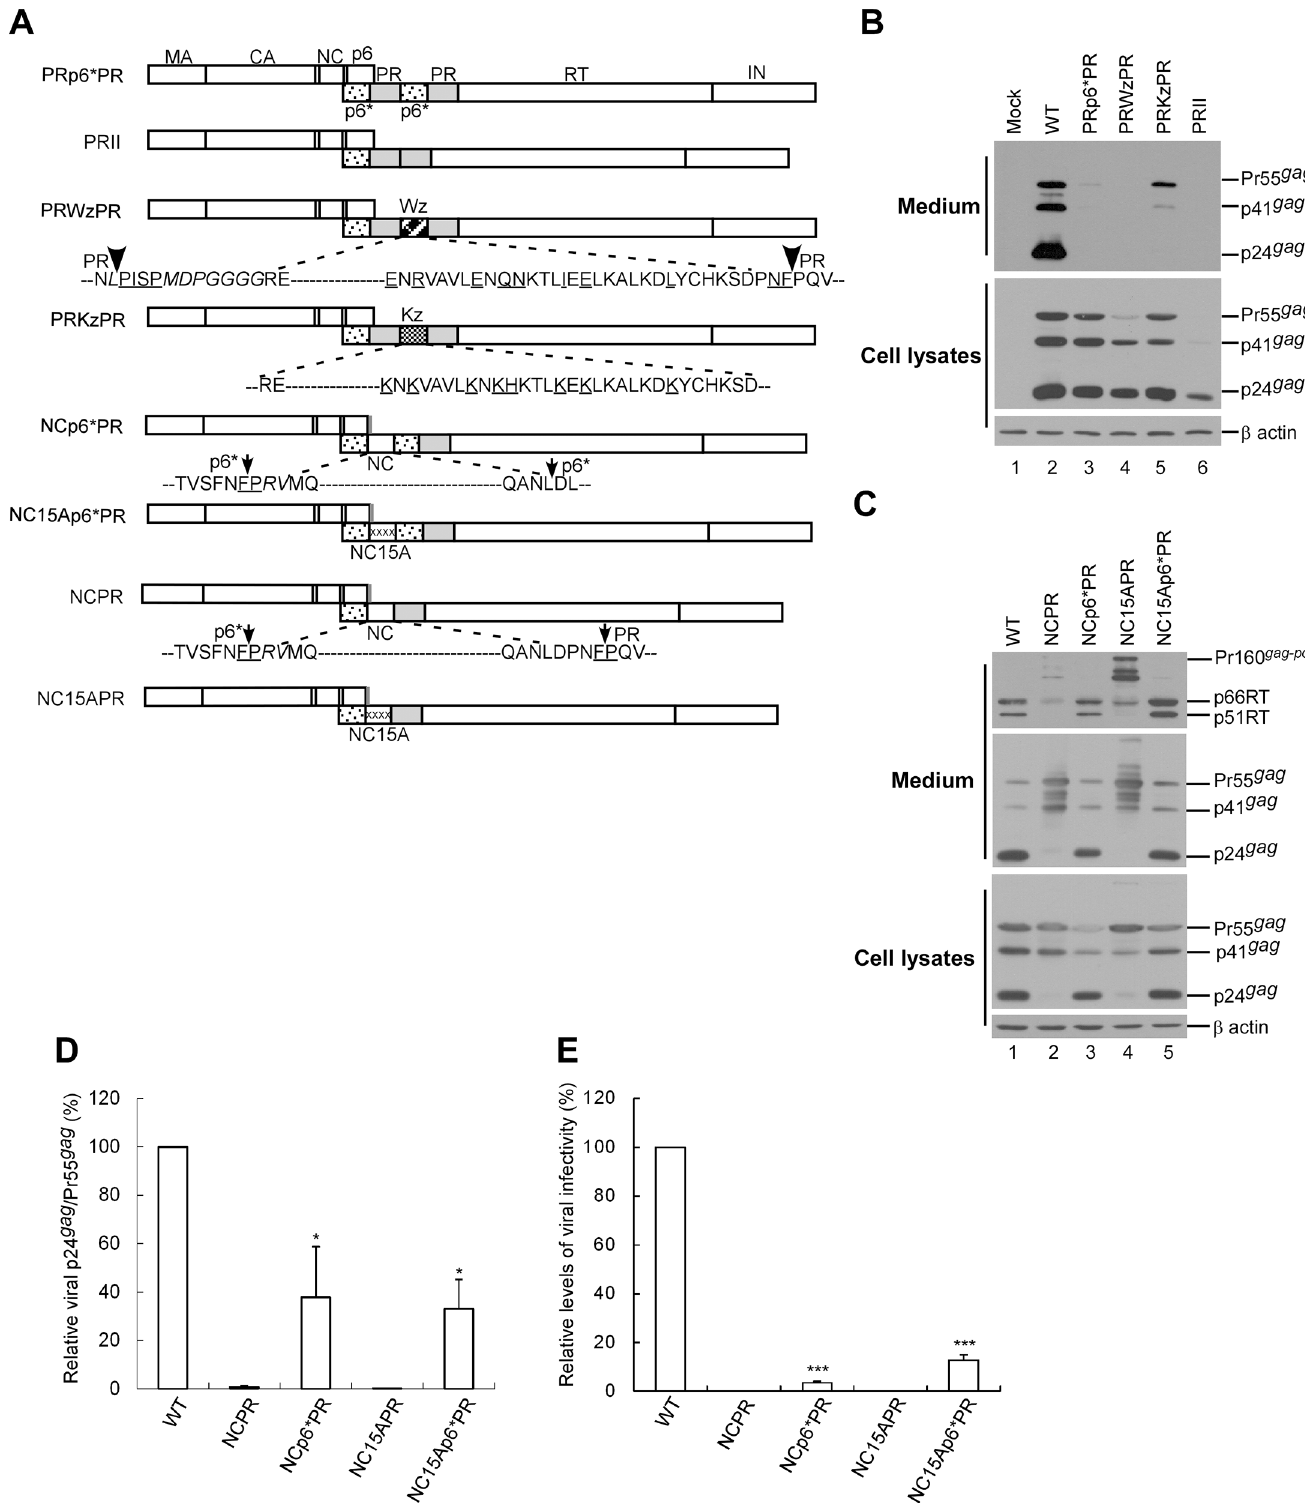
Fig 6. Effects of p6 * deletions or substitutions on Gag processing. (A) Schematic representations of HIV-1 Gag and Gag-Pol expression constructs. HIV-1 Gag protein domains and pol -encoded proteins are indicated as described in the Fig 1 caption. X denotes a PR-inactivated mutation. “ Wz ” and “ Kz ” boxes denote wt and mutant leucine zipper domains, respectively. The mutant LZ contained Lys or His residue replacements for the wt amino acid